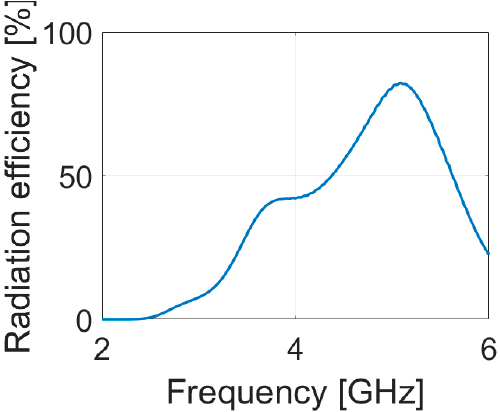
Figure 9. Radiation Efficiency (%) of the optimized SsDRA.